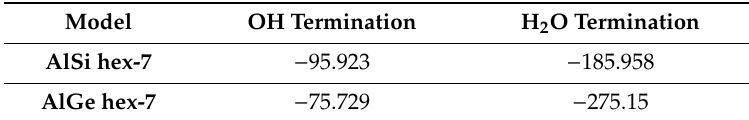
Table 2. Computed grand-canonical formation energy (E form , eV) for the the OH and H 2 O termination of the AlSi and AlGe hex-7 models.